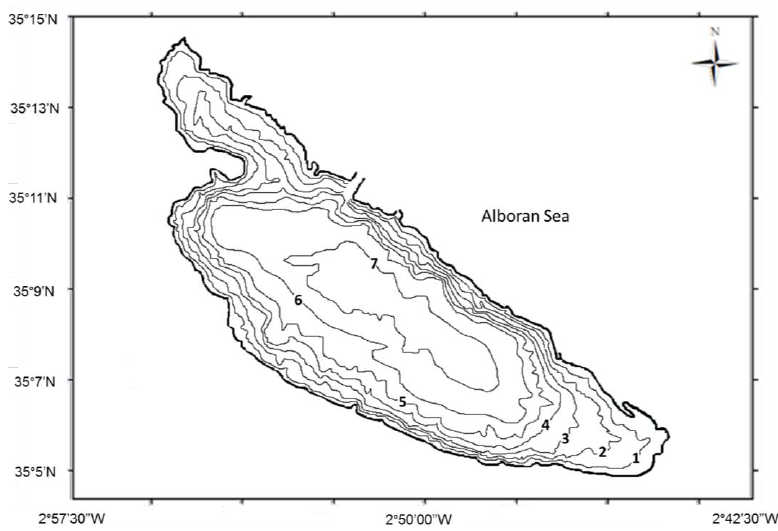
Figure 2. Bathymetry of Nador lagoon [15].